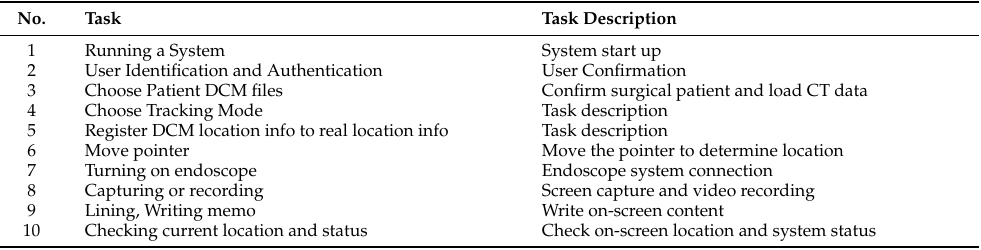
Table 2. Tasks for sinus surgical navigation system.